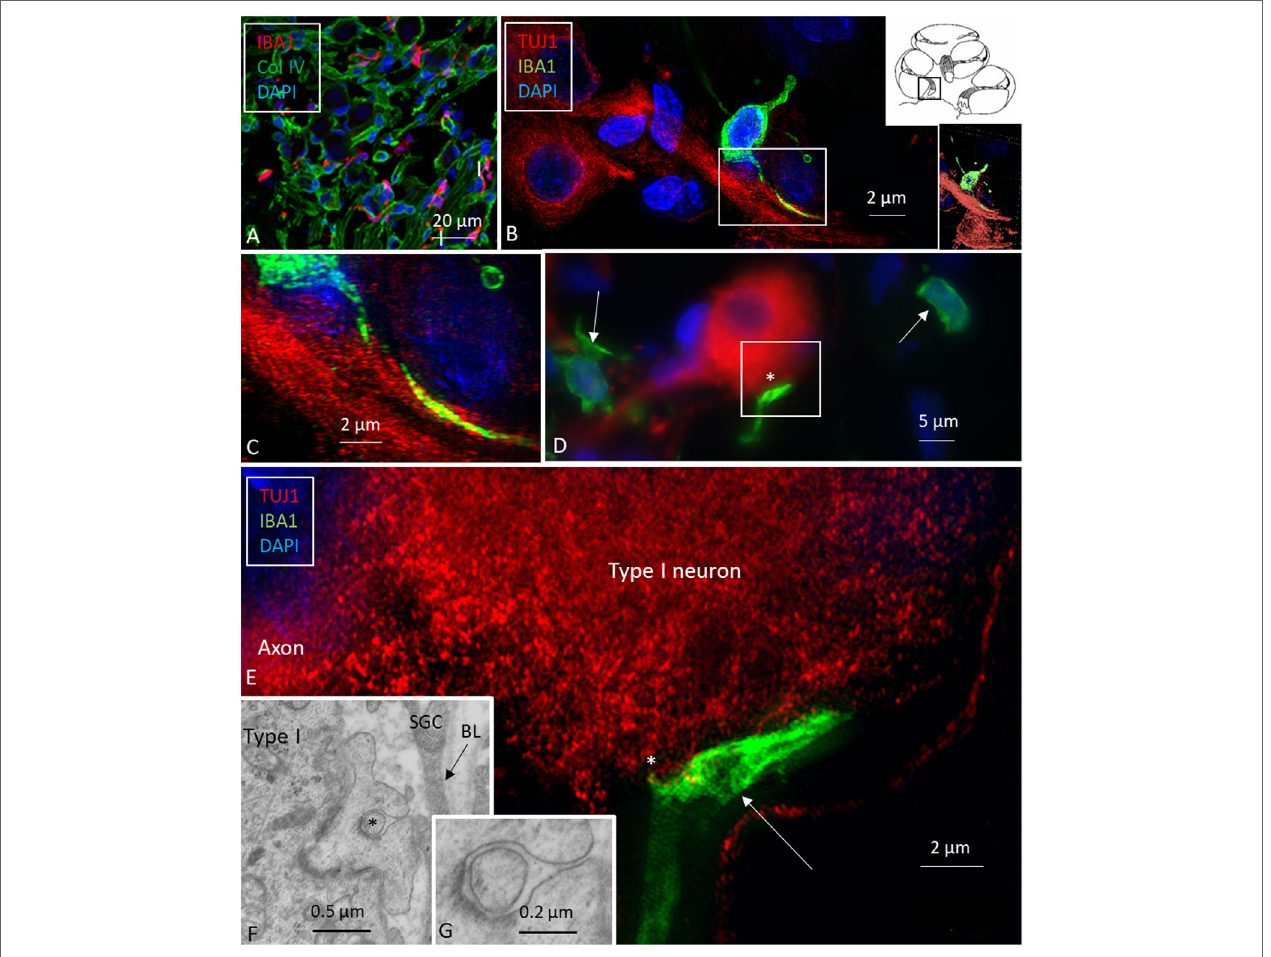
FigUre 4 | Ionized calcium-binding adaptor molecule 1 (IBA1) macrophages are physically related to spiral ganglion cells. (a) Confocal microscopy of immunohistochemistry for collagen IV and IBA1 in the spiral ganglion of the basal turn of the human cochlea. (b) SR-SIM of an IBA1-immunoreactive cell that projects into the cytoplasm of an axon process. Framed area is shown in higher magnification in panel (c) . Inset shows 3D video reconstruction shown in Video S1 in Supplementary Material. (D) Unprocessed SR-SIM showing TUJ1-positive type I spiral ganglion cell with associated IBA1 cell process (*) shown in panel (e) . Macrophage cell nuclei typically expressed IBA1 protein. (e) SR-SIM (maximal intensity projection) of the synapse-like IBA1 process facing the surface of the type I ganglion cell. A thin cell process (arrow) can be seen projecting into the neuron. (F, g) Transmission electron microscopy of unidentified cell processes directly facing the type I ganglion cell. There are cell membrane specializations and signs of possible cell